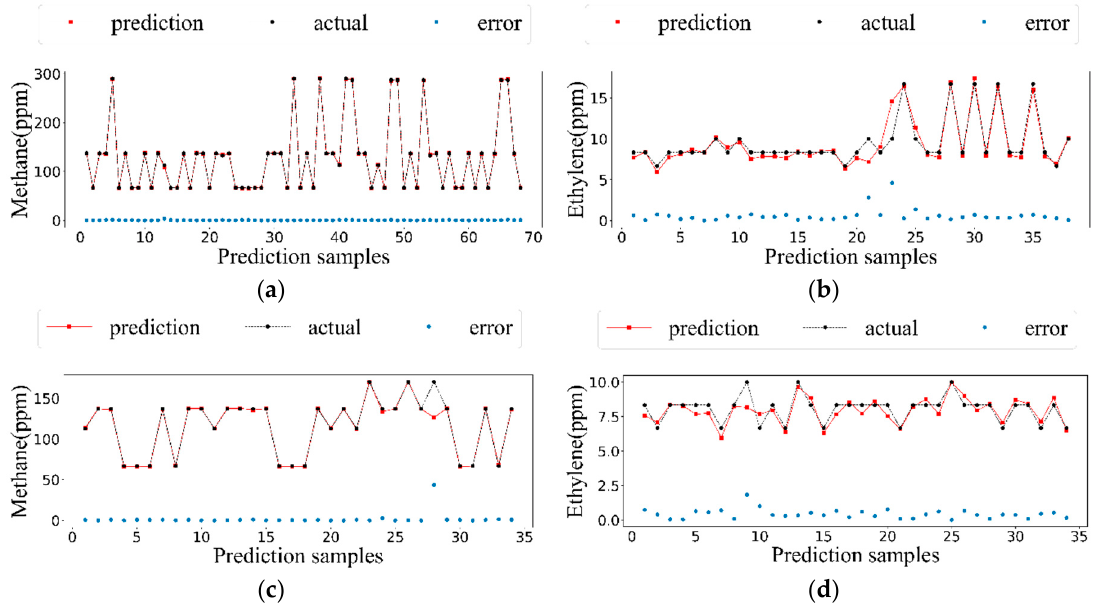
Figure 5. The predicted concentration along with the actual value. ( a ) The prediction and actual concentrations of single methane. ( b ) The prediction and actual concentrations of single ethylene. ( c ) The prediction and actual concentrations of methane in mixture. ( d ) The prediction and actual concentrations of ethylene in mixture.